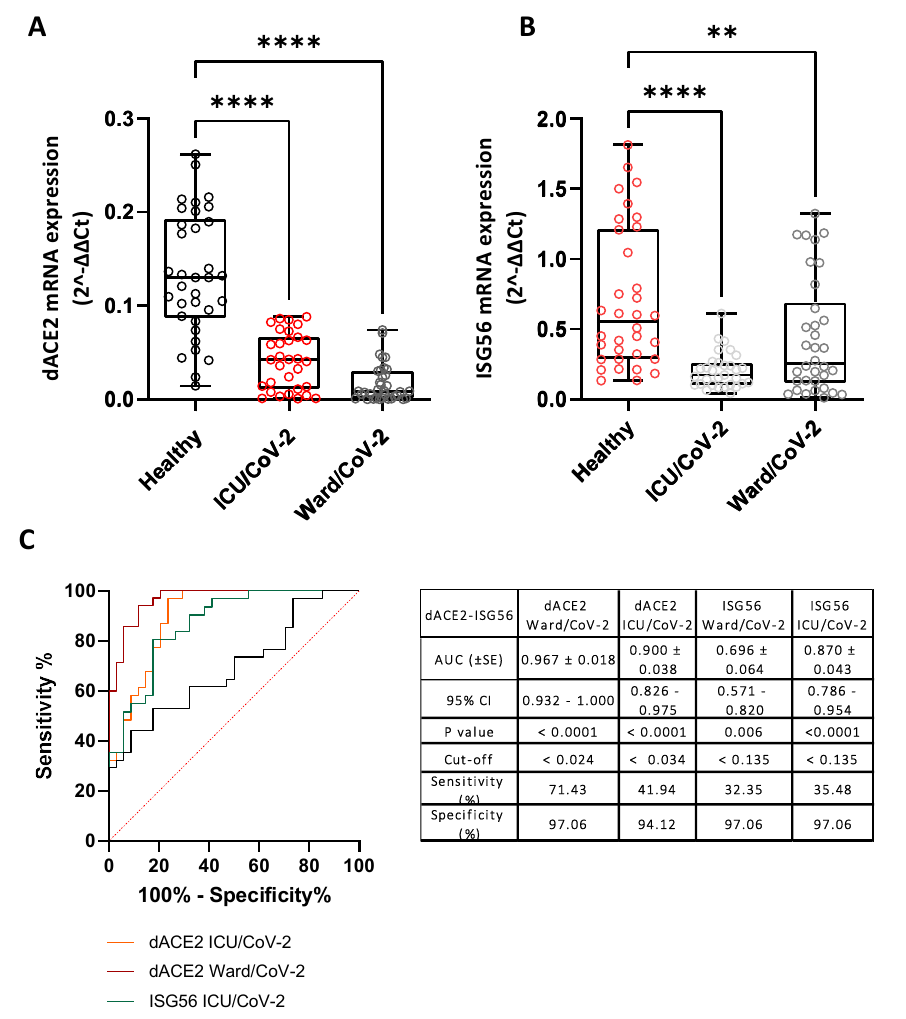
Figure 5. Comparison of the dACE2 ( A ) and ISG56 ( B ) expression in whole blood samples of healthy subjects (Healthy) and COVID-19 hospitalized patients (ICU/CoV-2, Ward/CoV-2 groups) and their ROC curve analysis ( C ). The mRNA expression data are presented as box plots and dots; line in the middle, median; box edges, 25th to 75th centiles; whiskers, range of values. p -values were calculated with the non-parametric Kruskal–Wallis test. Dunn’s test was carried out for multiple comparisons. ROC curves were generated and AUC, 95% CI and cut-off points with their specificity and sensitivity were calculated. p -value was ** p < 0.01, **** p <